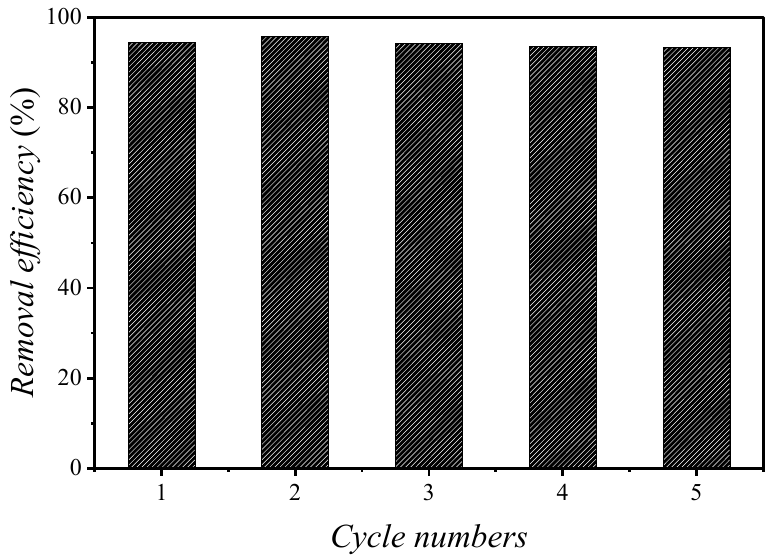
Figure 4. The recyclability of the PAA sponge after the adsorption of Pb(II).